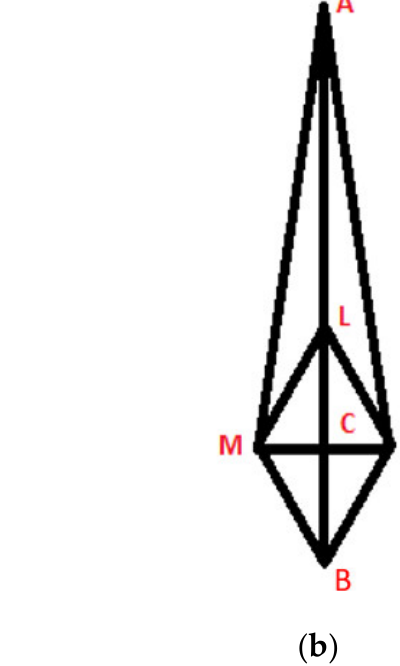
(1) Distances between four points to the cement–enamel junction (CEJ) and the apex (A), AM (mesial point apex), AD (distal point apex), BA (buccal point apex) and LA (lingual point apex) were evaluated with a digital caliber. To calculate the height of the pyramid on the buccal-lingual plane, the triangular sections (ACM and ACD triangles) were considered. The height was calculated, according